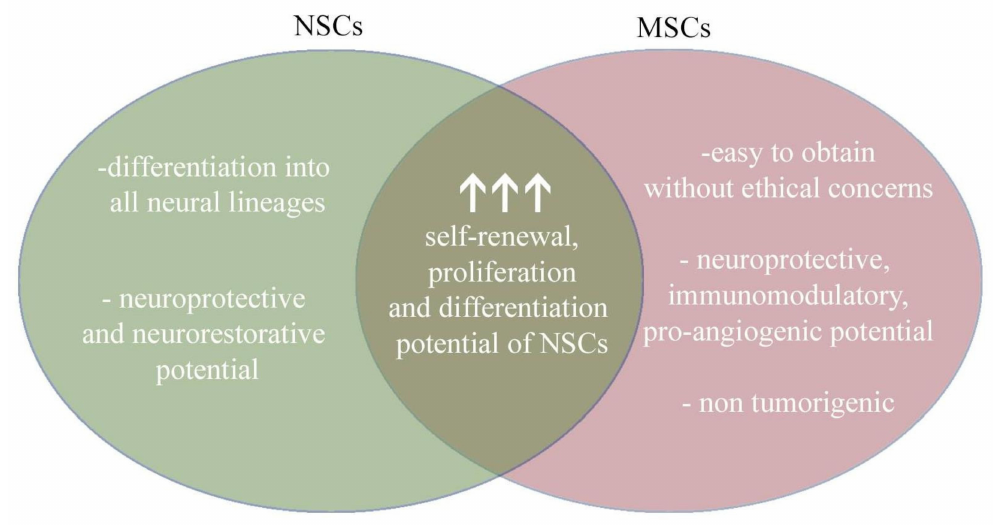
Figure 4. Combining the therapeutic benefits of NSCs and MSCs provide a new perspective for